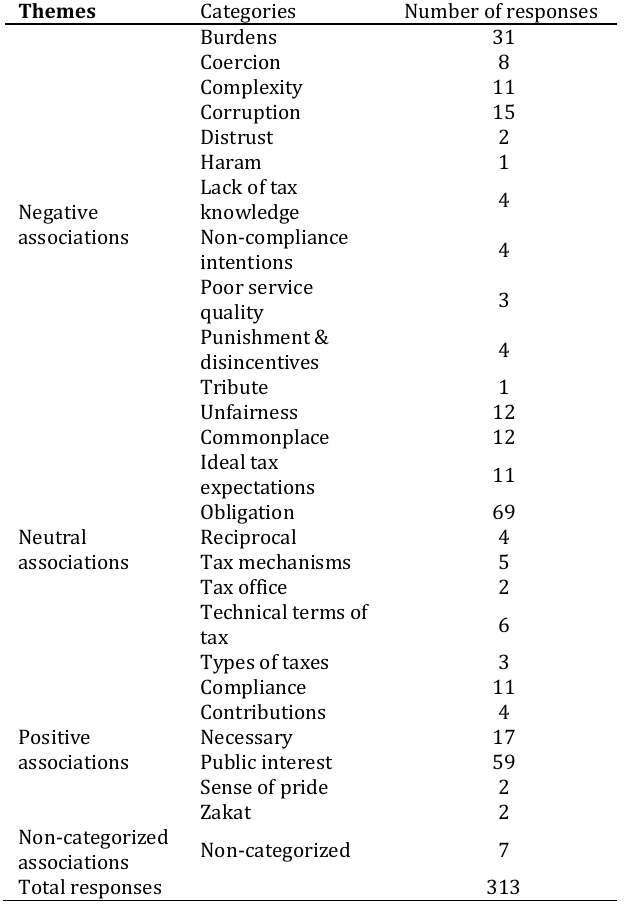
Table 1 Categories and theme discoveries of tax